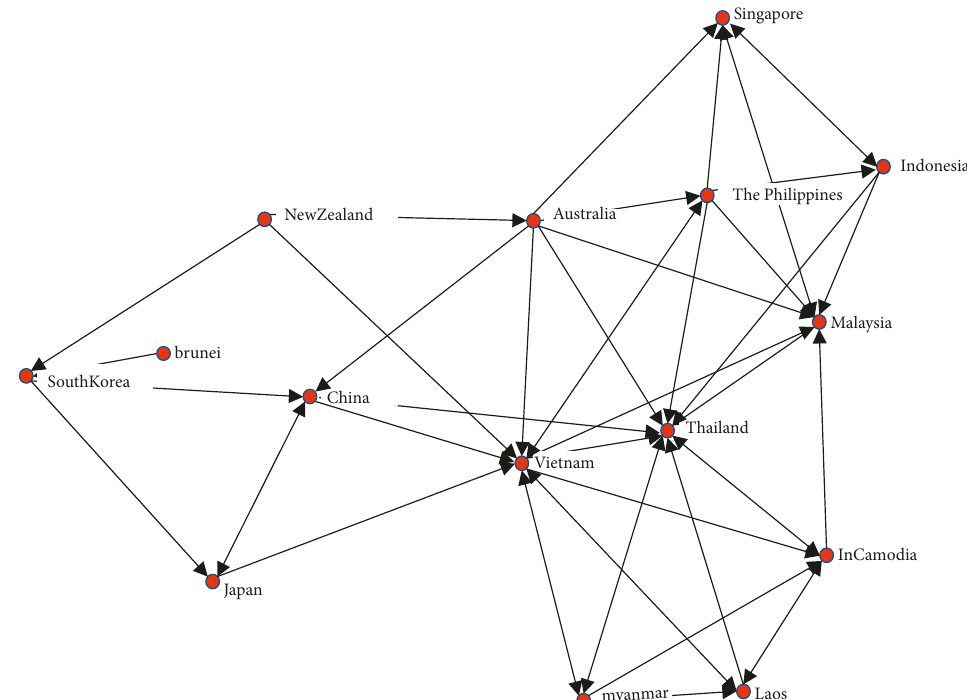
Figure 1: RECP countries’ trade spatial connection